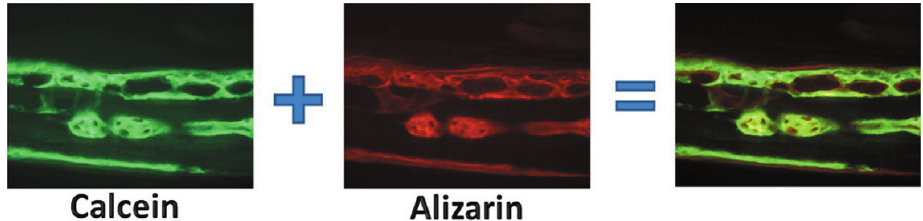
Figure 5- Standardization of the analyzed area. The square lines delimit the center of the defect, selected to be the analyzed area. The yellow arrow show the block graft and the white arrows show the boards of the defect